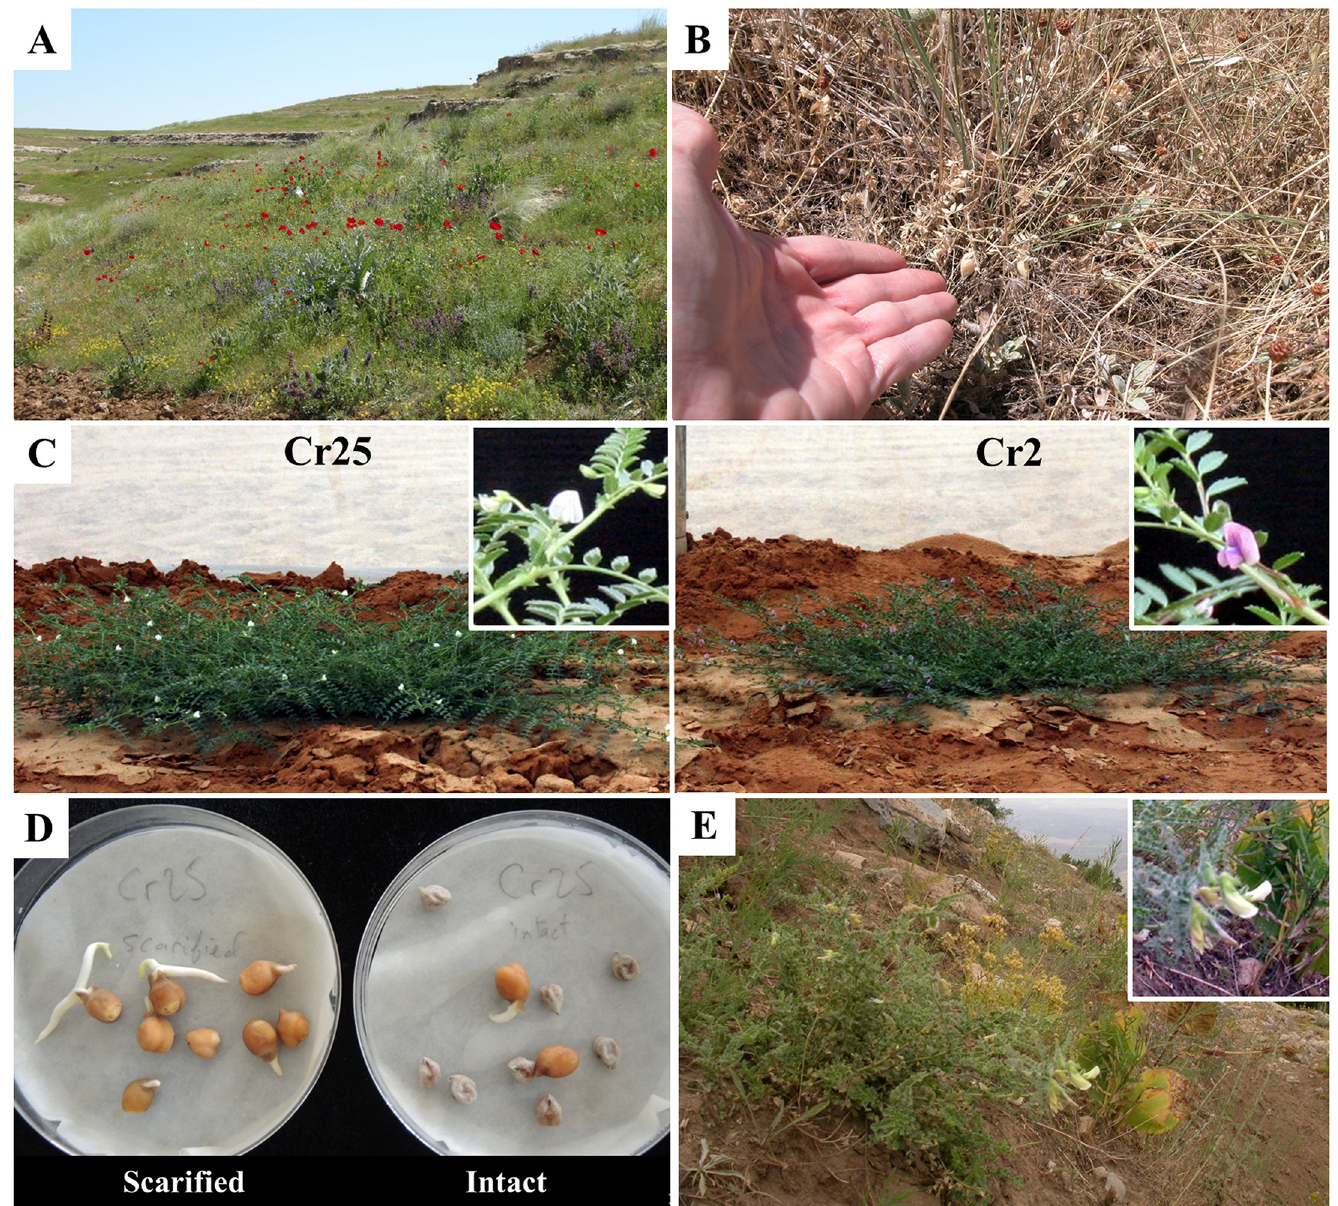
Fig 5. Wild Cicer reticulatum accession Cr25. ( A ) The habitat near Midyat, Turkey where Cr25 was sampled, photographed in May 2009. ( B ) A mature wild C . reticulatum plant in the source population of Cr25 on the occasion of seed sampling, June 2007. ( C ) Growth habit and flower colour of Cr25 as compared with a typical C . reticulatum accession (Cr2). ( D ) The seed germination pattern of Cr25. Right, intact 5 months old seeds. Left, control (scarified) 5 month old seeds. ( E ) A perennial Cicer sp. with white flowers. Photograph taken on Mt. Kizilnora, Uzbekistan, July